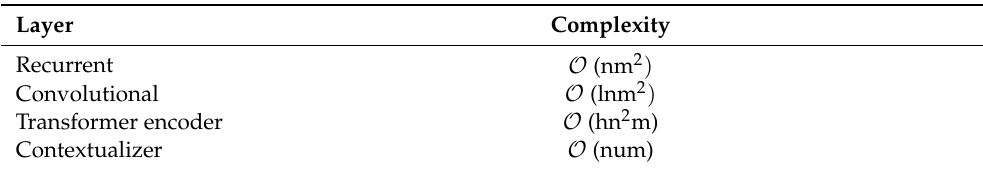
Table 1. Complexities of common layers used in NLP; l designates the kernel size, h , the number of attention heads, n , m and u , designate the length of the sequence, the dimension of the word representations and the multiplicative dimension, respectively. For Transformers and Contextualizers, the complexity is for a single contextualization